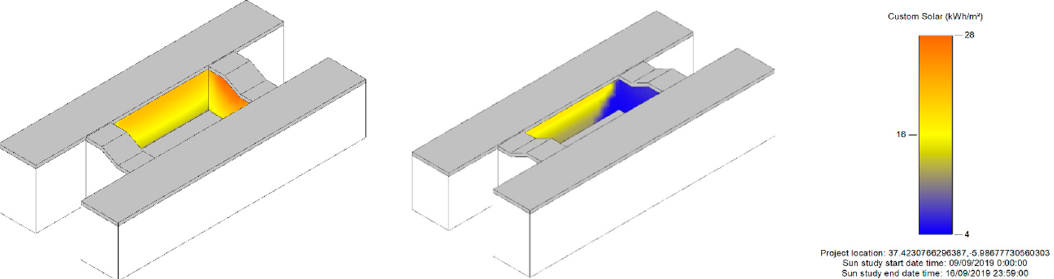
Figure 8. Case study 1: Cumulative insolation from 9th September to 16th September.